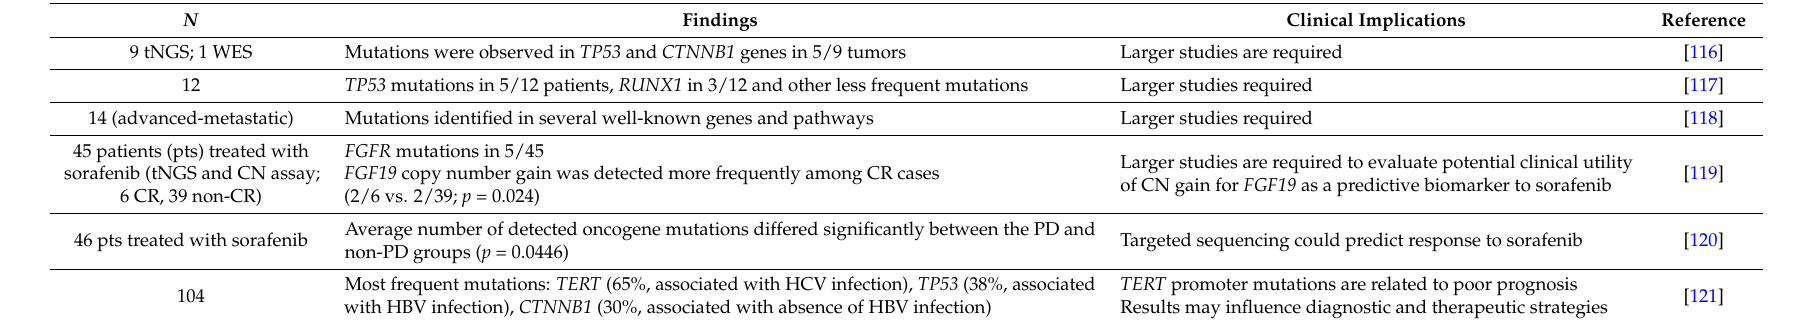
Table 5. Targeted next-generation sequencing studies on hepatocellular